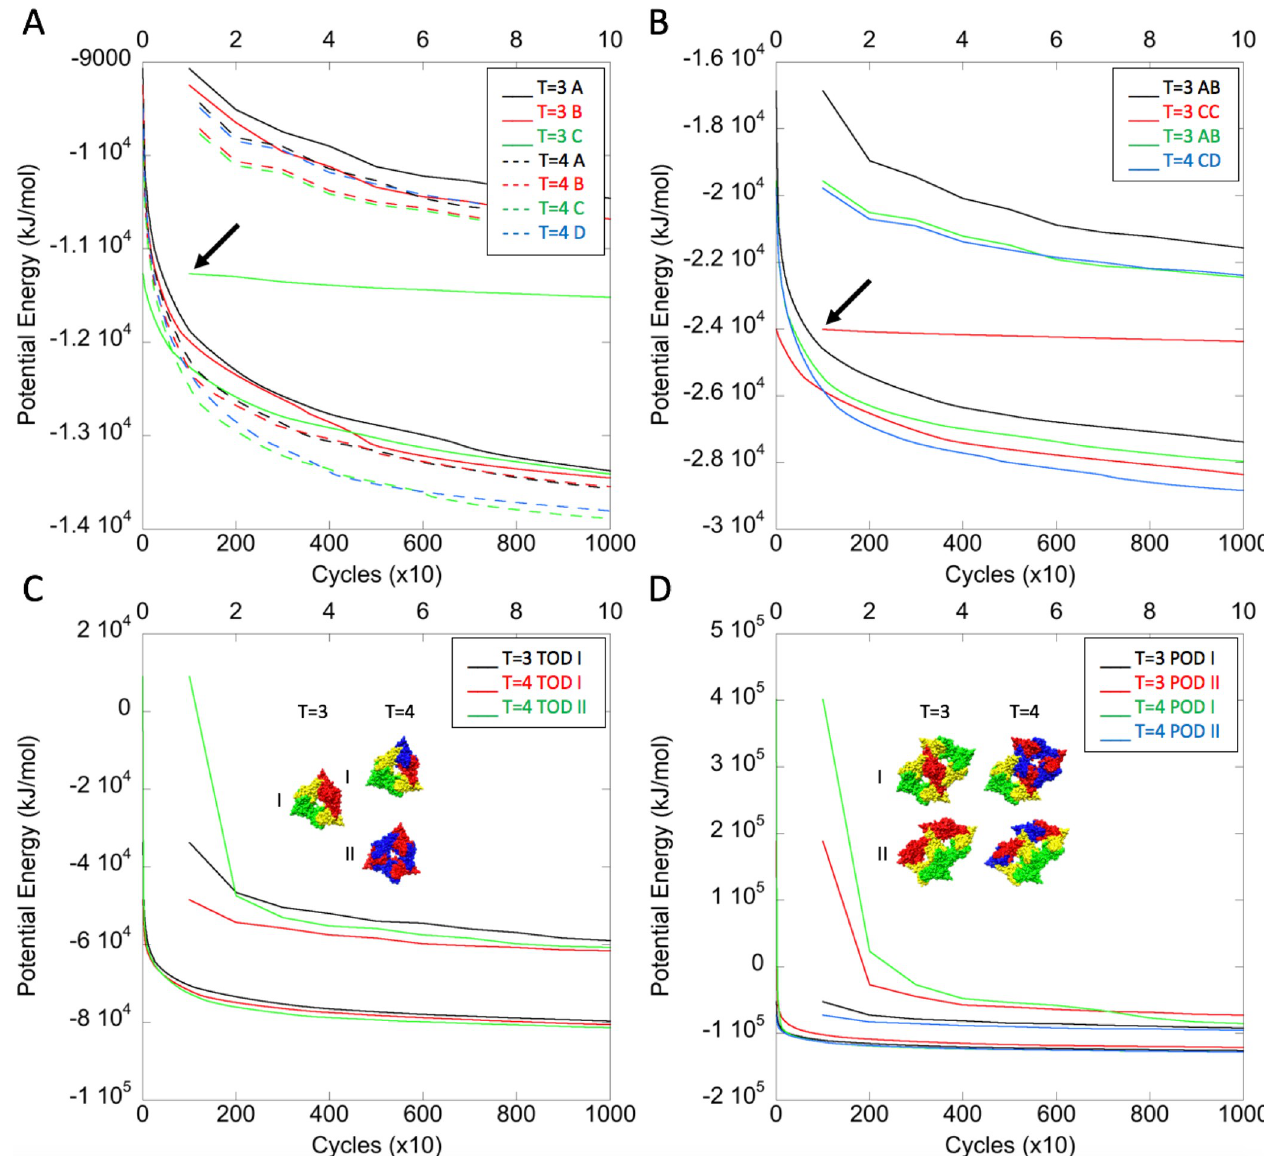
Fig 7. Potential energy minimization of T = 3 and T = 4 capsid substructures. (A) Monomers, (B) Dimers, (C) Trimers-of-dimers, and (D) Pentamers-of- dimers. In all panels, the lower curves show energy minimization for 10,000 cycles and the upper curves show the first 1,000 cycles on an expanded scale (upper X-axis). In each panel, line styles and colors pertain only to that panel. Arrows indicate the curves for the particularly low-energy T = 3 C monomers and T = 3 CC dimers in (A) and (B) as plotted on the expanded X-axis. Models of the Type I and Type II trimers-of-dimers and Type I and Type II pentamers-of-dimers are shown inset in (C) and (D), respectively. For the locations of the structures shown in (C) and (D) in the context of the capsids see Fig